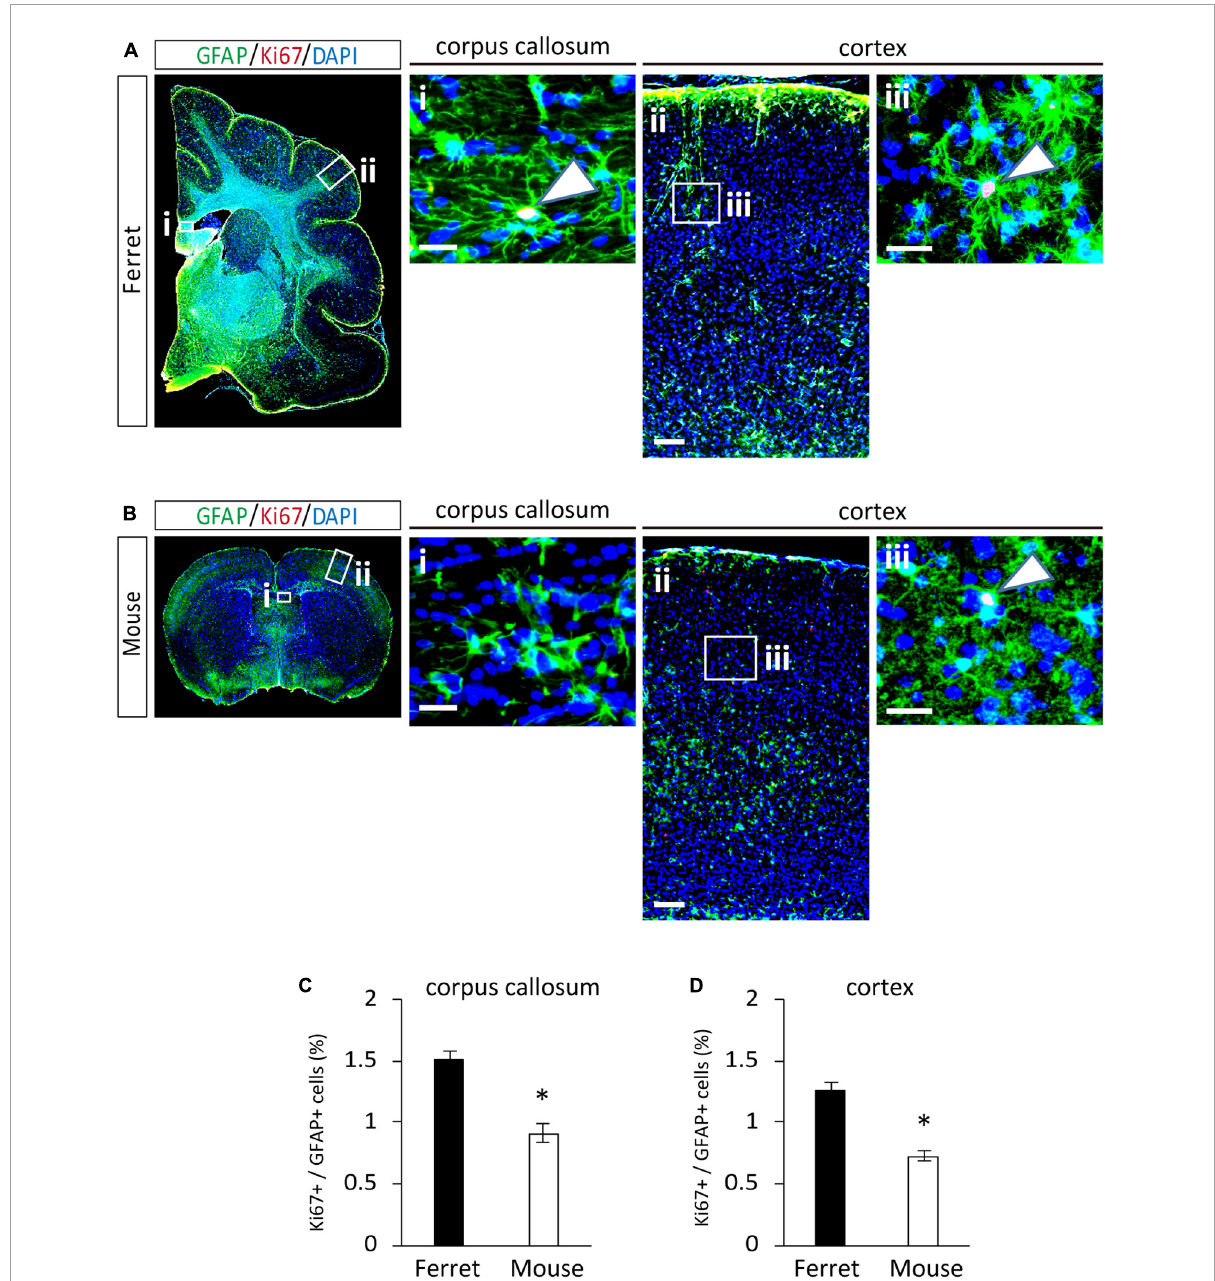
FIGURE6 Proliferation of ferret and mouse astrocytes in the adult brain. (A,B) Representative images of GFAP and Ki67 in the cortex and corpus callosum of adult ferret at P100 (A) and mouse at P70 (B) . Nuclei were stained with DAPI (blue). Arrows indicate Ki67-positive astrocytes. (C,D) Proportion of Ki67-positive cells in GFAP-expressing astrocytes in the corpus callosum (C) and cortex (D) of ferret and mouse brains. Scale bars = 100 µ m in (A i) and (B i) ; 200 µ m in (A ii) and (B ii) ; and 50 µ m in (A iii) and (B iii) . n = 4 animals each group. Data represent the means ± SEM. The P -values were determined using paired Student’s t -test. ∗ P <